Question: Write the caption for this figure.
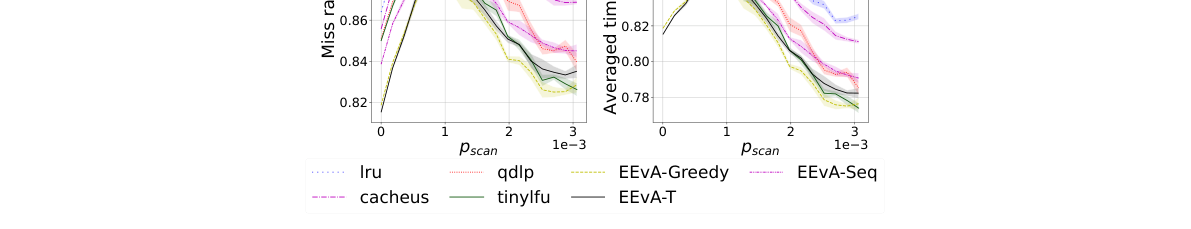
Answer: EEvA-based algorithms show the lowest miss rate and averaged time cost uniformly for the considered range of pscan values. The presented mean and variance values are computed over 5 runs.